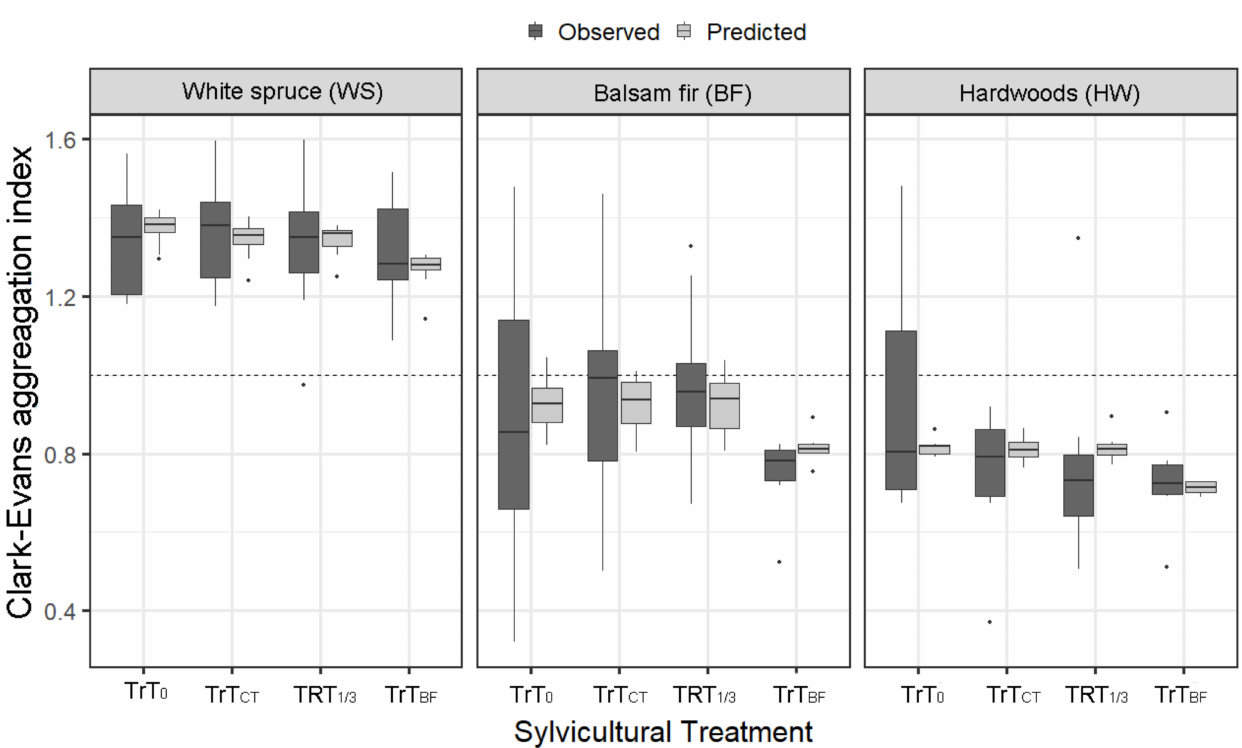
Figure 3. Box plots of observed (dark grey bars) and predicted (light grey bars) values of the Clark and Evans aggre- gation index, by species group (Gsp) and silvicultural treatment, for all trees. See Table 2 for definitions of Gsp and treatment abbreviations. Table 3. Parameters estimations (standard error) of the model selected to predict aggregation